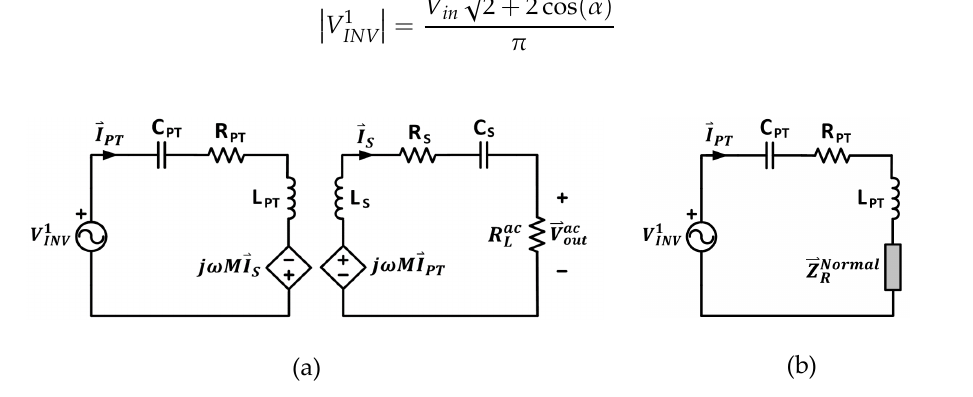
Figure 5. Simplified equivalent circuit of the proposed system when operated in normal mode: ( a ) Overall circuit; ( b ) Reflected impedance in primary circuit.